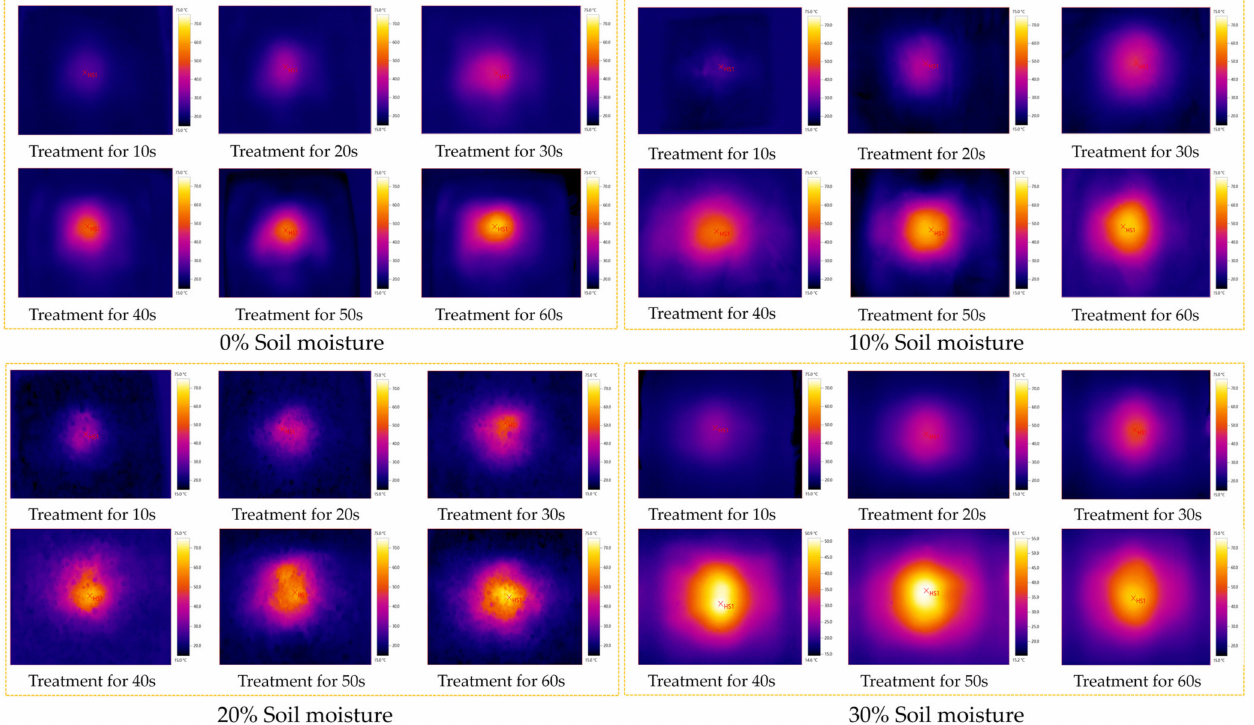
Figure 11. Thermal images of the soil surface at a microwave output power level of 1.8